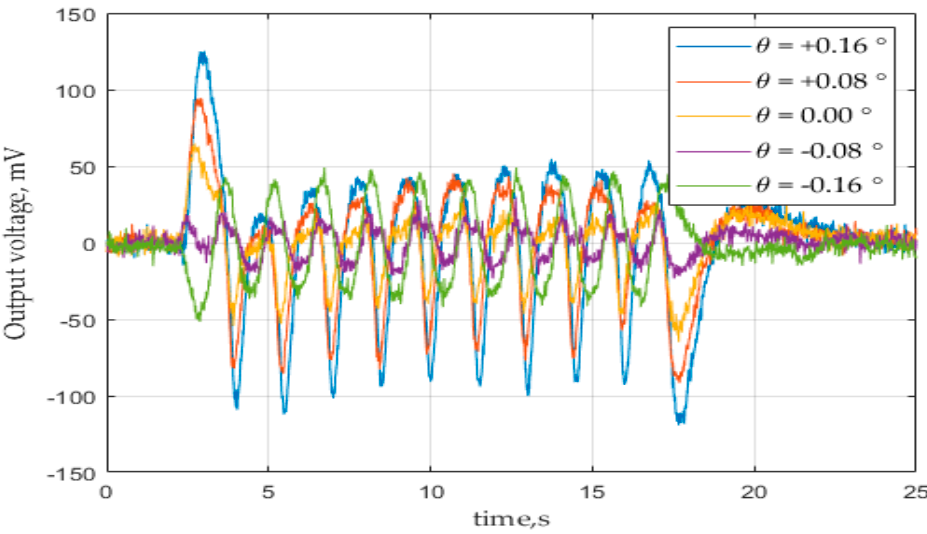
Figure 8. Output voltage signal of PIR sensor module over time at different turned angles.